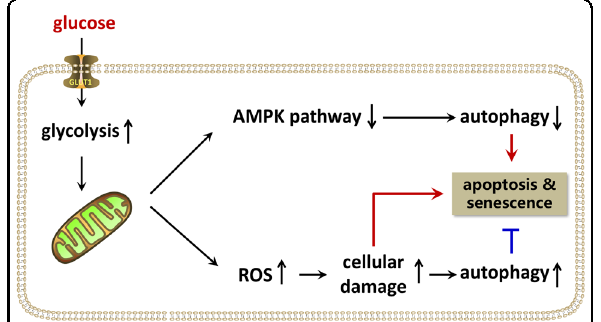
Fig. 7 A schematic diagram of the dual effect of high glucose on autophagy in chondrocytes. High glucose suppresses autophagy through the AMPK pathway while it induces autophagy via oxidative stress in